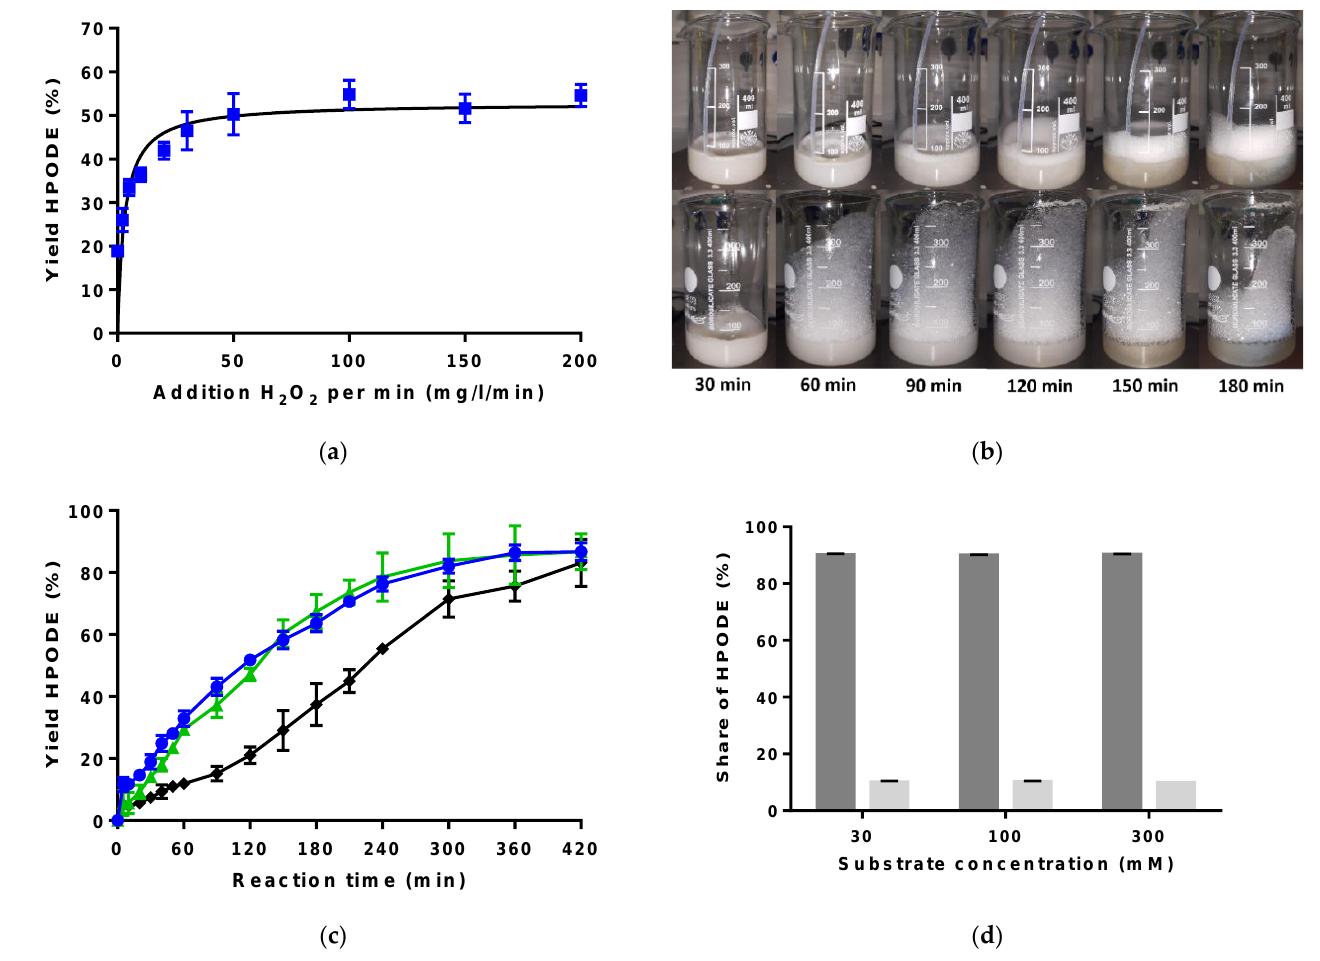
Figure 5. ( a ) Dependence of H 2 O 2 flowrate on LOX-catalyzed hydroperoxidation in the presence of M. lysodeikticus catalase at a linoleic acid concentration of 30 mM after 2 h of reaction; ( b ) Foam evaluation with safflower oil equivalent to 30 mM linoleic acid, top row: 3-enzyme system with catalase and in situ oxygen generation, bottom row: lipase + LOX system with oxygen bubbling; ( c ) Hydroperoxidation yields with LOX-1 from Sigma, lipase and catalase in Tris HCl buffer pH 8 with = safflower oil equivalent to 30 mM, = 100 mM and = 300 mM linoleic acid; ( d ) Analysis of the regioisomer ratio (13:9) of products obtained from reaction shown in ( c ) with percentage of 13-HPODE ( ) and 9-HPODE ( ). (cid:32)